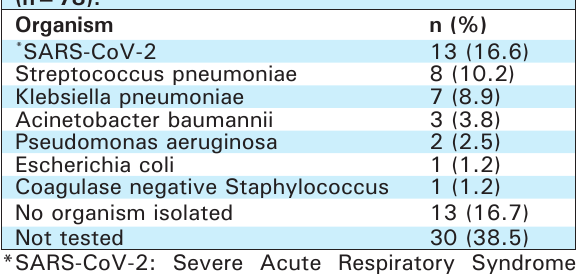
Table 2. Microscopic examination of sputum sample